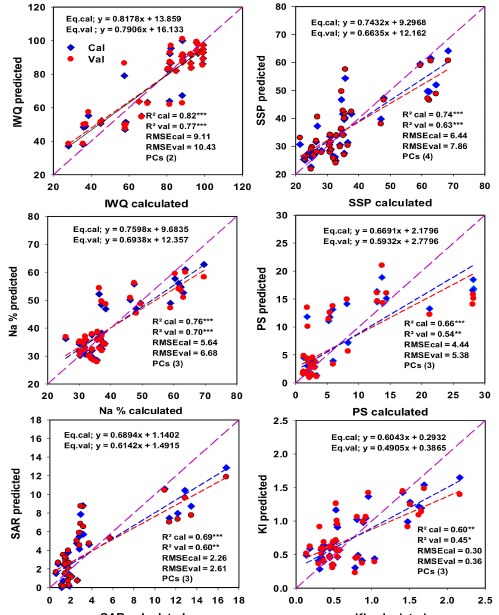
Figure 8. Coe ffi cient of determination (R 2 ), root mean squared error (RMSE), and equation (Eq) for calibration (R 2 cal , RMSE Cal , and Eq cal ) and validation (R 2 val , RMSE Val , and Eq val ) of the relationship between calculated and predicted values of di ff erent irrigation water quality indicators (IWQIs): irrigation water quality (IWQ), percent sodium (%Na), sodium absorption ratio (SAR), soluble sodium percentage (SSP), potential salinity (PS), and Kelly’s index (KI) of partial least squares regression (PLSR) models based on fourteen di ff erent spectral reflectance indices (SRIs). Estimates were calculated across the Western Desert and Central Nile Delta ( n = 40).*, **, *** indicate statistical significance at the 0.05, 0.01, and 0.001 probability levels, respectively. PCs indicate number of latent